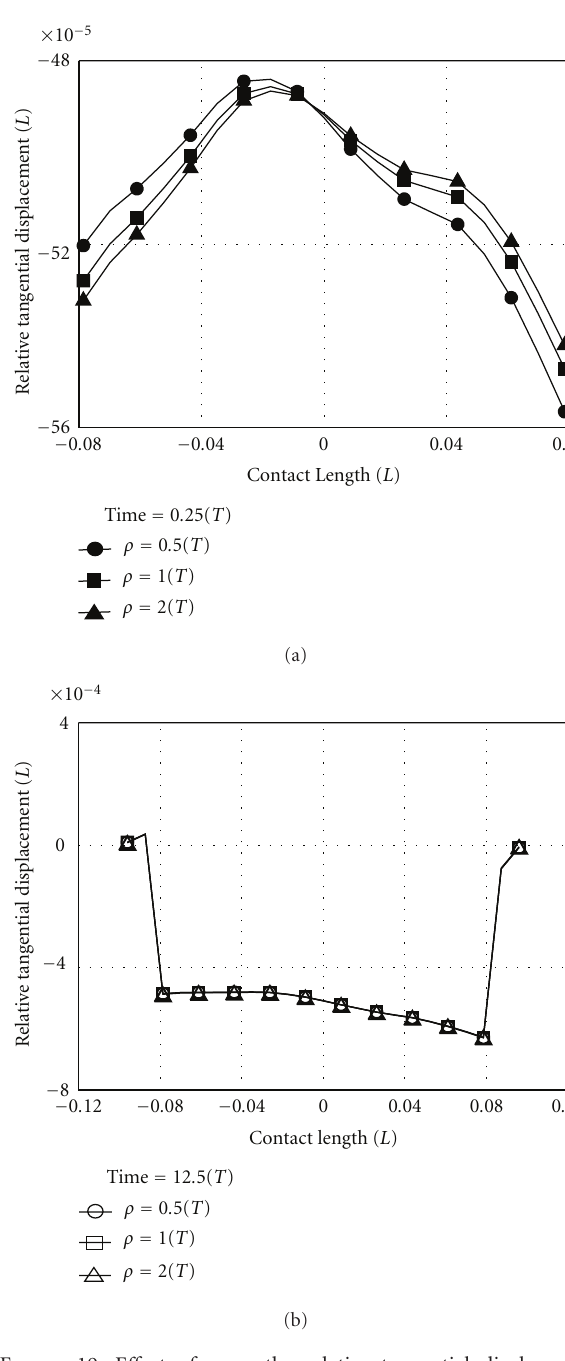
Figure 19: E ff ect of ρ on the relative tangential displacement